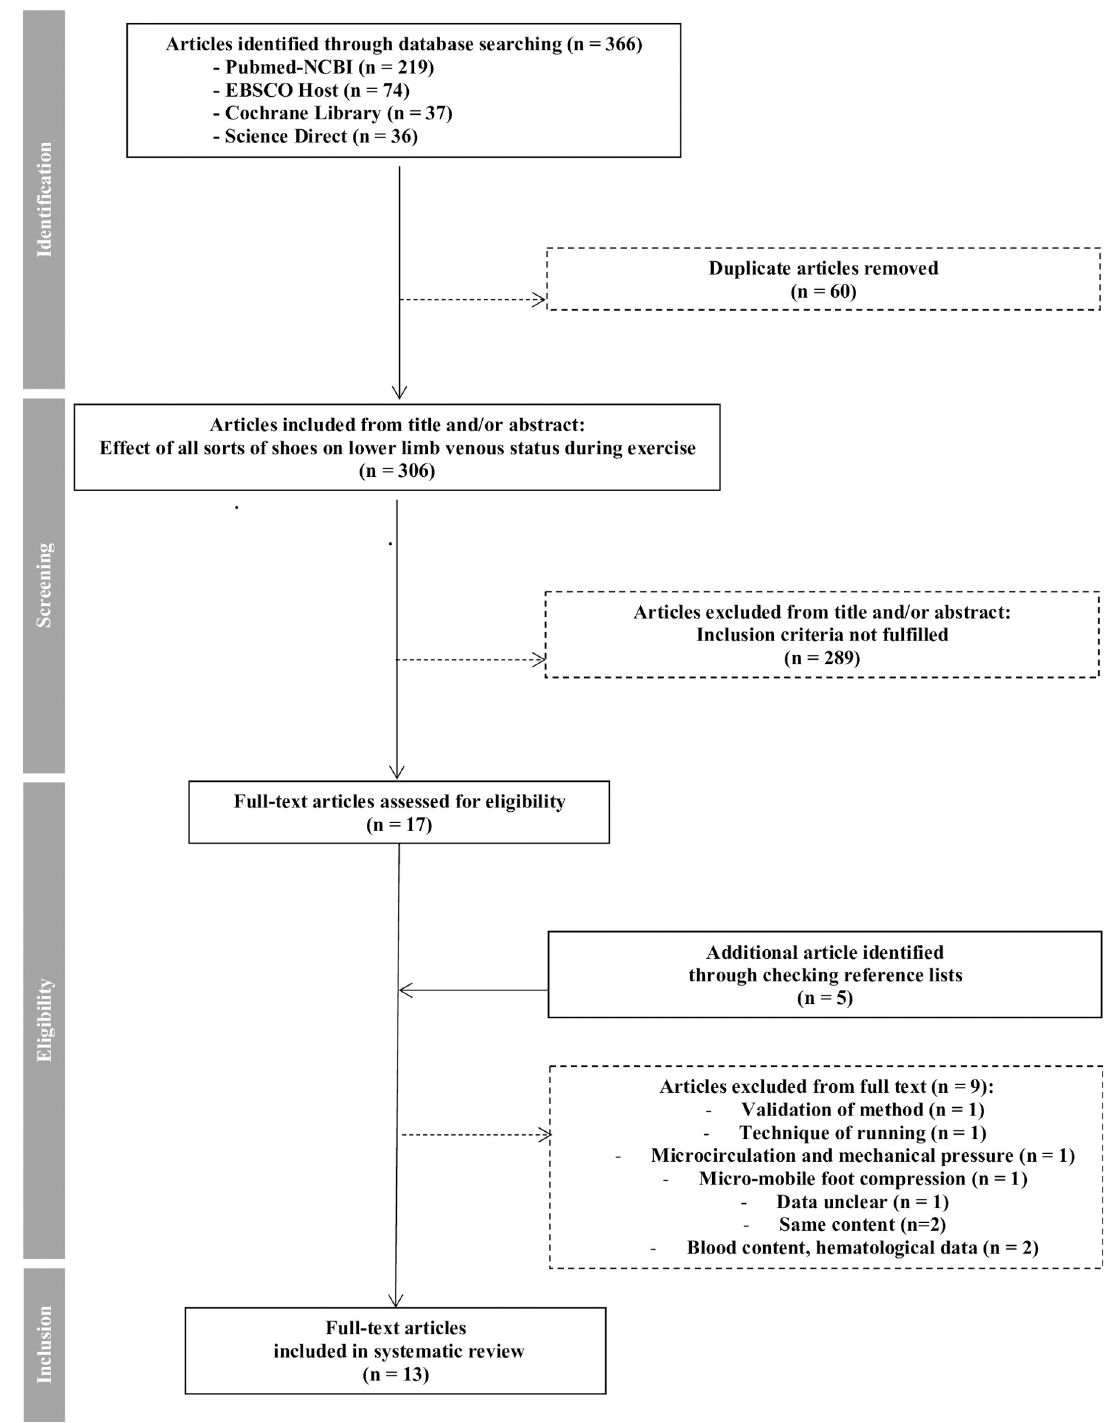
Fig 1. Flow diagram of study selection. Figure presents the flow of information through the different phases (identification, screening, eligibility and inclusion) of a systematic review.